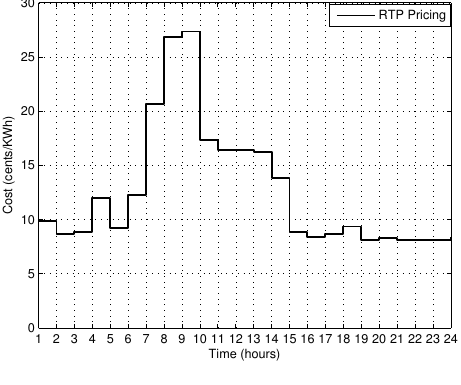
Figure 4. RTP price